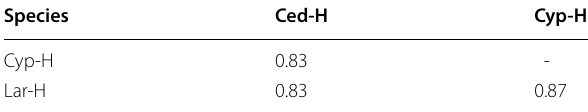
Fig. 7 Kaplan–Meier curves observed in the deterioration of heartwood at the three sites. Color‑coded areas indicate 95% confidence intervals. Table 7 Adjusted p value between each